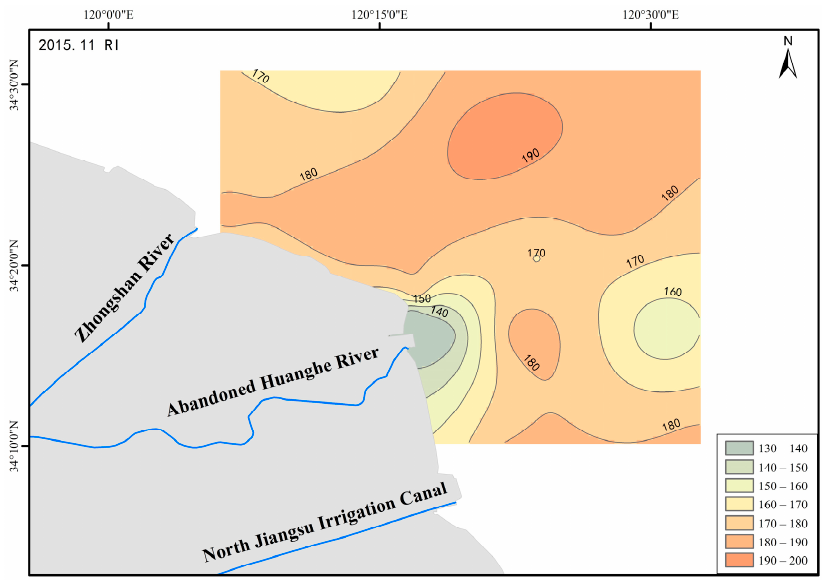
Figure 3. Distribution map of the comprehensive potential ecological risk index in 2015.